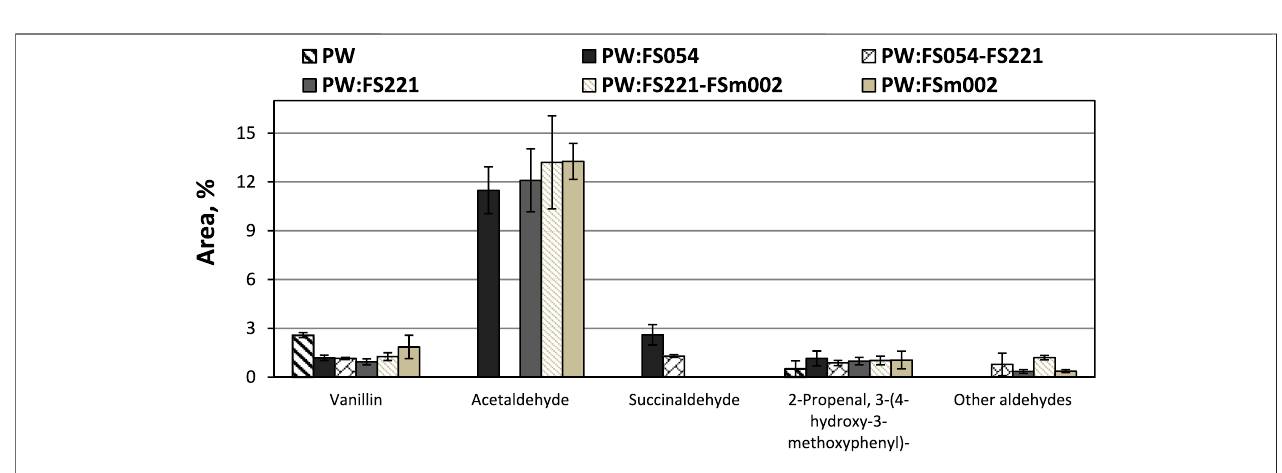
FIGURE 9 | Effect of mono- and dual-sized α -Fe 2 O 3 catalyst particle mixtures on the PW CFP aldehyde distribution.